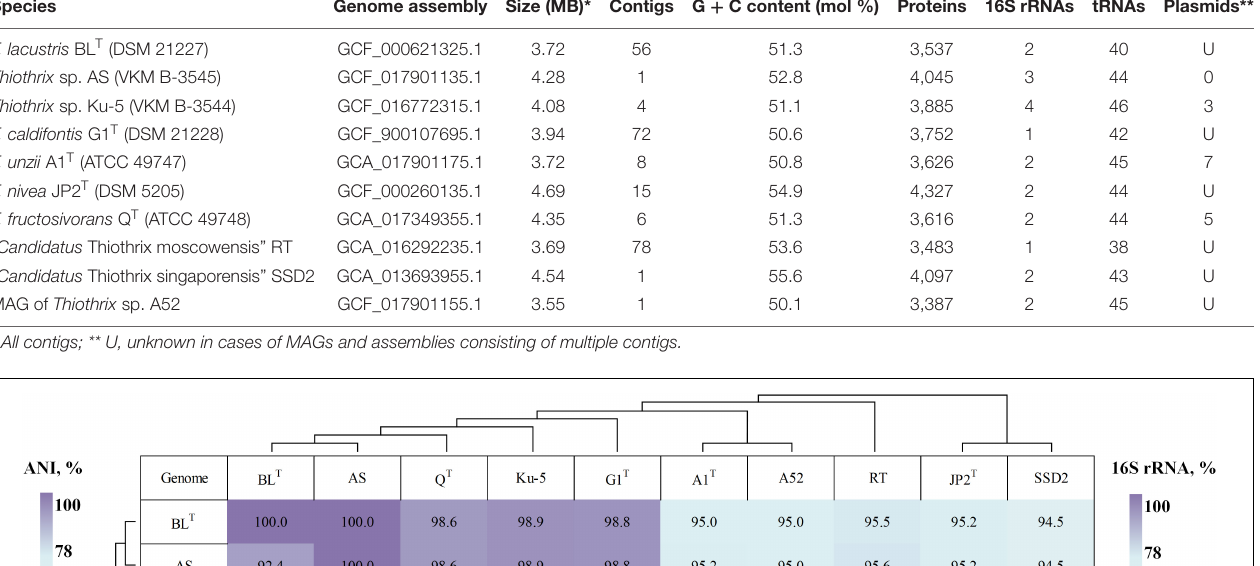
TABLE 2 | The general properties of assembled Thiothrix genomes that were used for pangenome analysis.